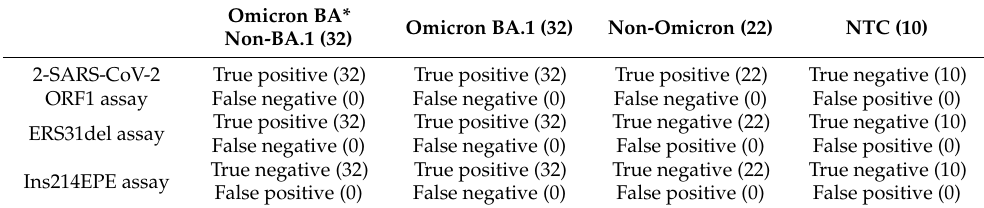
Table 3. Multiplex RT-qPCR specificity test on 96 samples